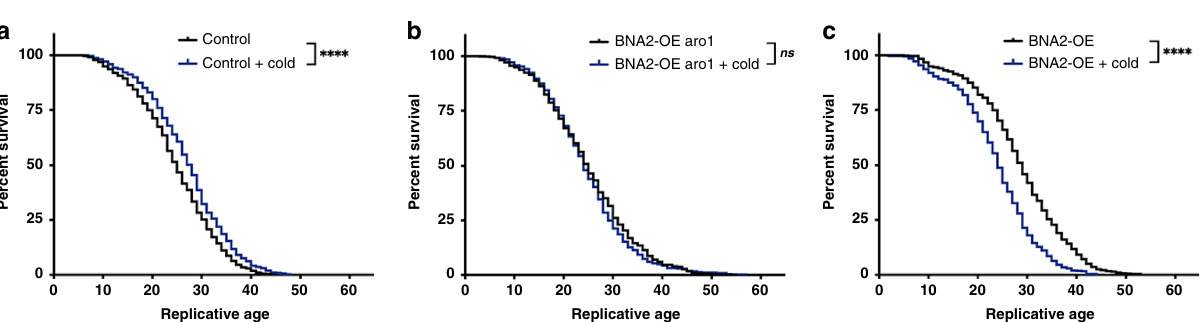
Fig. 3 SA pathway metabolite levels anti-correlate with lipid droplet levels during aging. a The SA-BNA pathway, including metabolite names, genes , and sources of crosstalk (purple dashed arrows) between the aromatic amino acid synthesis and BNA pathways. b – i Ratios of metabolites from glycolysis, the shikimate and aromatic amino acid pathways, and the BNA pathway are plotted black, red, or blue, respectively. b Middle-aged Control (WT, AB18-07) and BNA2 -OE cells were analyzed by global metabolomics (see Methods). Measurements of speci fi c metabolites (arbitrary units) detected from n = 3 independent experiments were normalized to cell counts within each experiment. The normalized measurements from BNA2 -OE cells were divided by the normalized measurements from Control (WT) cells for each experiment, and these ratios were then averaged and plotted as a ratio of metabolite levels in BNA2 -OE versus control cells ± SEM (see Supplementary Fig. 4 and source data). c – i Cells as indicated were analyzed by targeted metabolomics (see Methods and source data). Measurements of speci fi c metabolites detected in the shikimate (red symbols) or BNA (blue symbols) pathways in Control (WT, AB18-07, dots), BNA2 -OE (squares), BNA2 -OE aro1 (triangles), and BNA2 -OE bna6 (diamonds) cells were normalized to cell counts, averaged from n = 4 independent experiments and reported as arbitrary units ± SEM. #Below limit of detection. Paired t -test (two-tailed): p ≤ 0.05 indicated in fi gure panels; **** p ≤ 0.0001; p > 0.05 indicated as ns (not signi fi cant). j Model for the mechanism by which BNA2 -OE suppresses the accumulation of lipid droplets during aging and extends lifespan. Aged Control (WT) cells accumulate lipid droplets during normal aging. BNA2 overexpression ( BNA2 -OE) decreases lipid-droplet accumulation by pulling some substrates away from lipid droplets through the shikimate and aromatic amino acid (SA) pathways toward the BNA pathway. A deletion in ARO1 prevents BNA2 -OE from pulling fl ux through the SA pathway and from suppressing lipid-droplet accumulation during aging, whereas lifespan extension by BNA2 -OE correlates with increasing the branch point metabolite xanthurenate. Source data for ( b – i ) are provided as a Source data fi le.